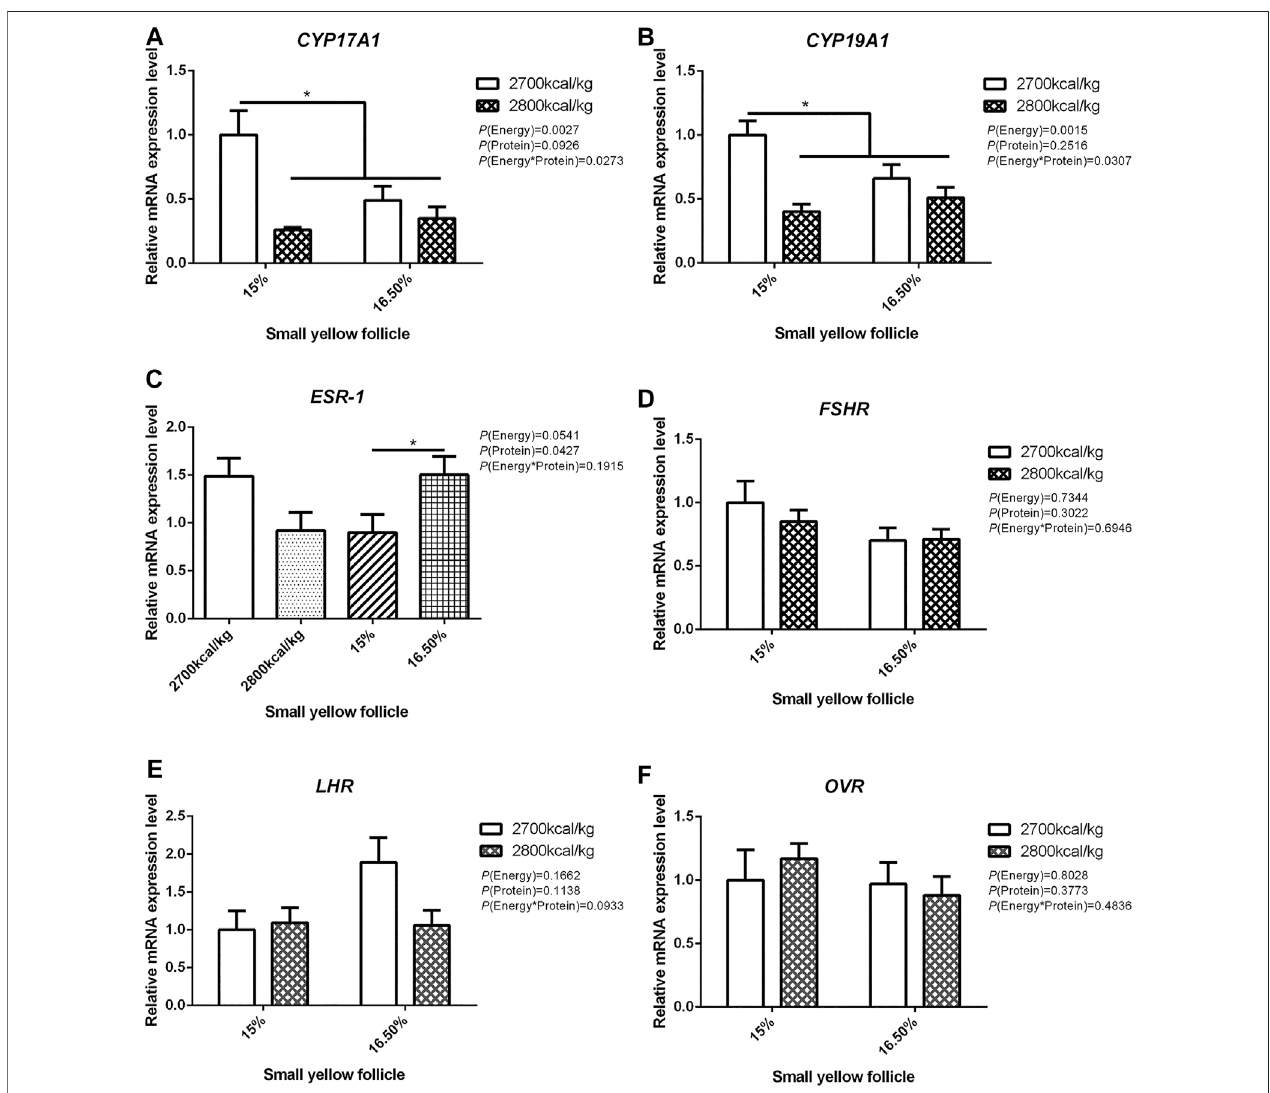
FIGURE5 | Effect of dietary metabolizable energy (E) and crude protein (P) levels during the prelay period (15 – 20 weeks of age) on themRNA expression of genes CYP17A1 (A) , CYP19A1 (B) , ESR-1 (C) , FSHR (D) , LHR (E) , and OVR (F) in the small yellow follicles of hens. Data represent the mean ± SD ( n = 4); p p < 0.05.